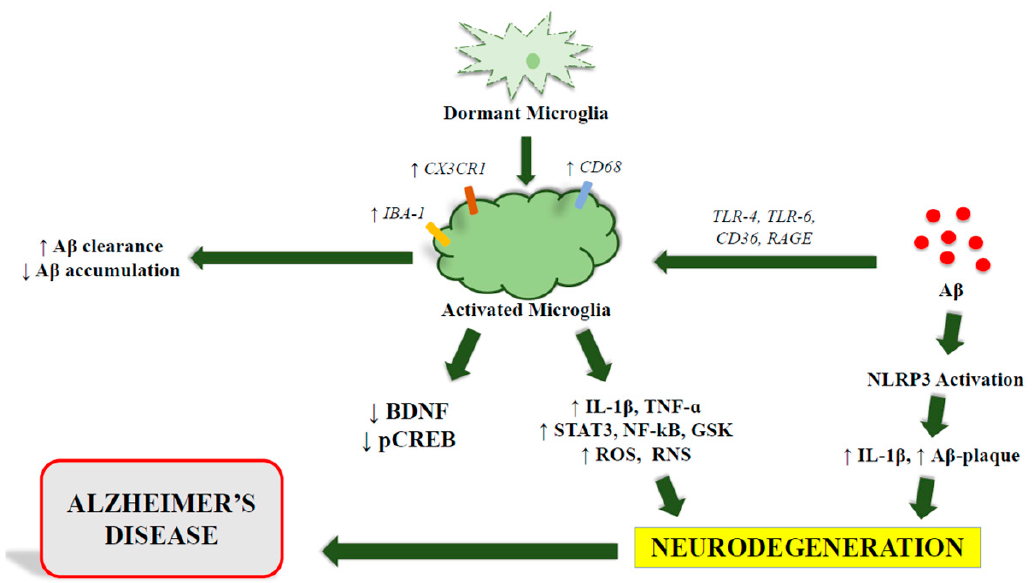
Figure 2. The role of microglia in AD. Microglia activation leads to the activation of various inflam- matory signaling pathways. Its continuous stimulation can cause neurodegeneration.